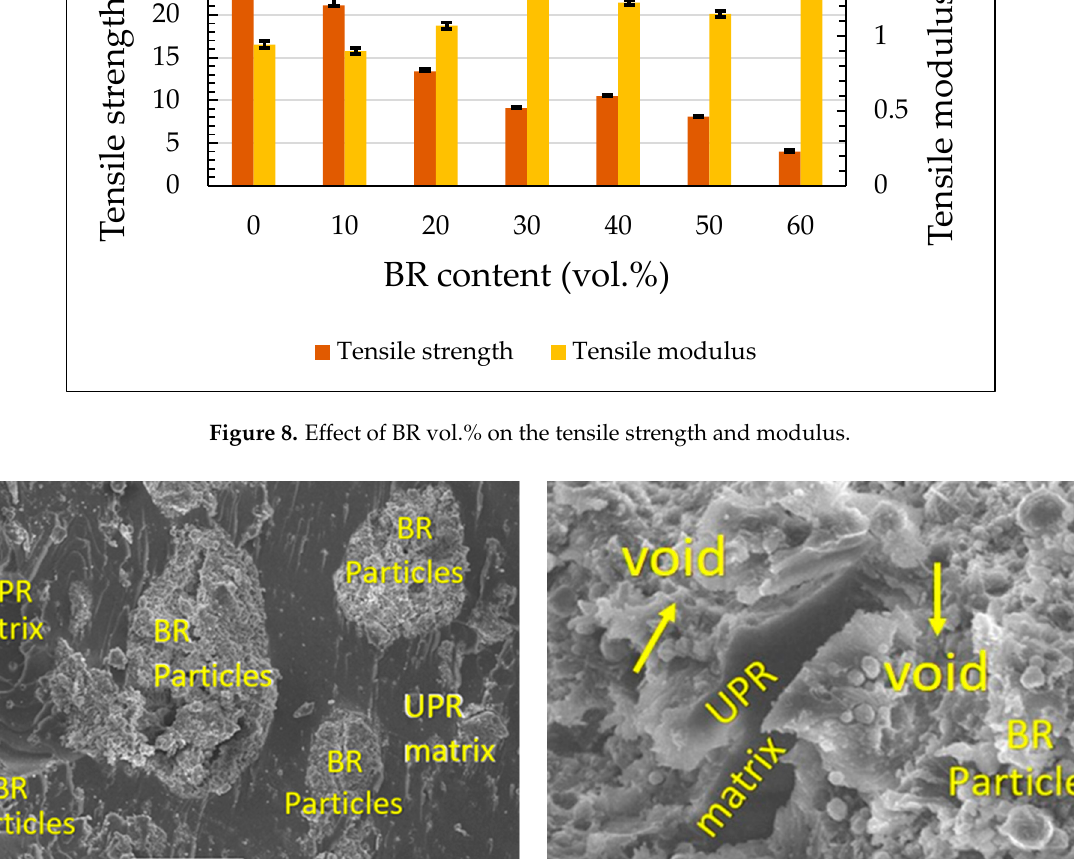
Figure 8. Effect of BR vol.% on the tensile strength and modulus.